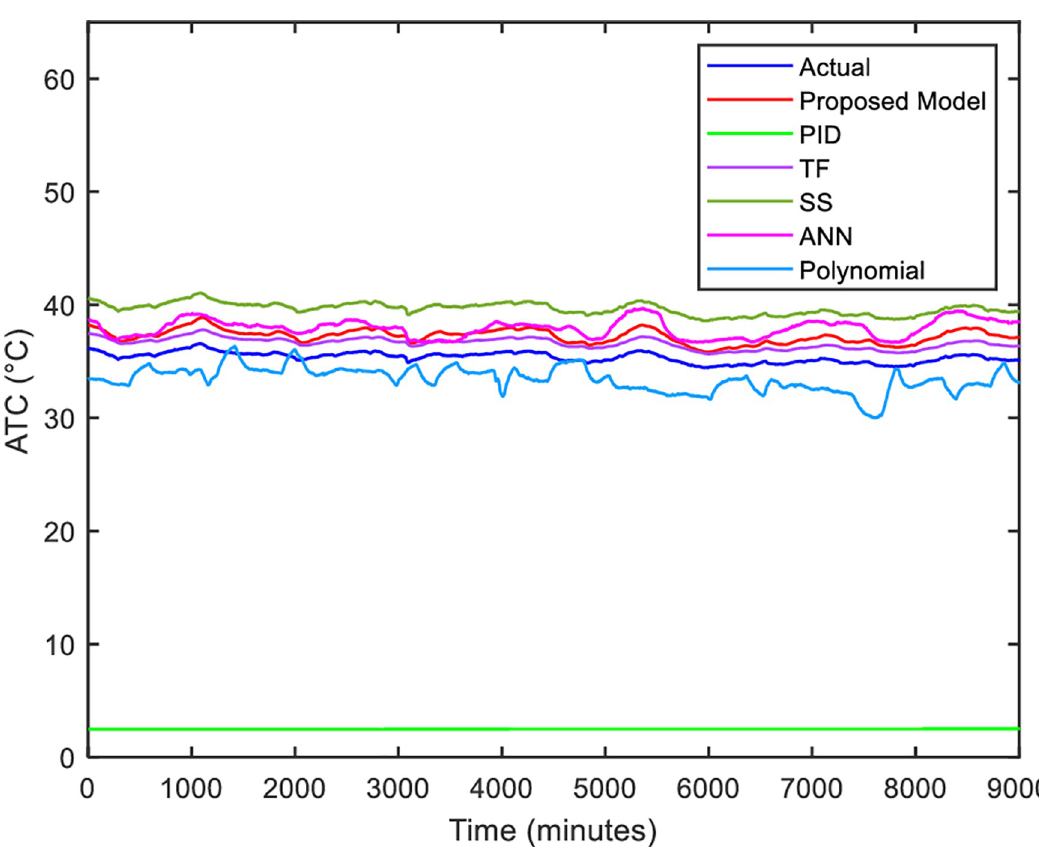
Fig 13. Comparison between actual and simulated cold air temperature, T